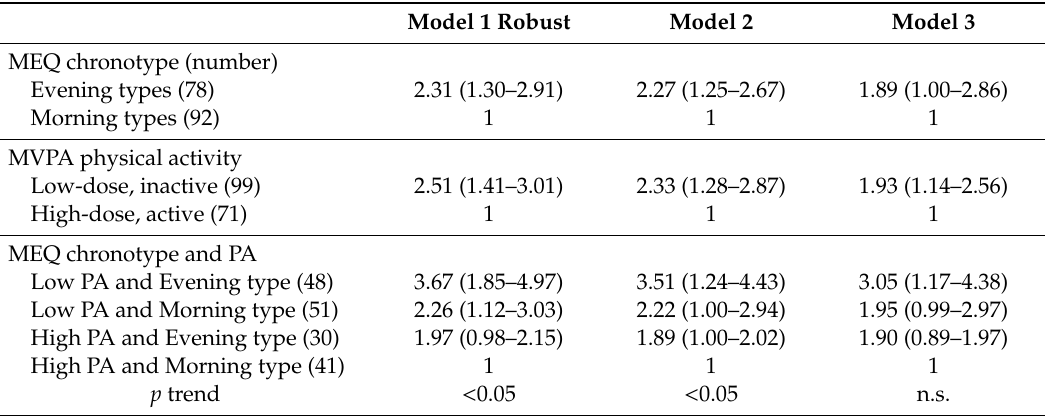
Table 4. Adjusted odds ratios (95% confidence intervals) for estimated dementia risk in the categories of chronotype and volume of daily physical activity (PA) in older